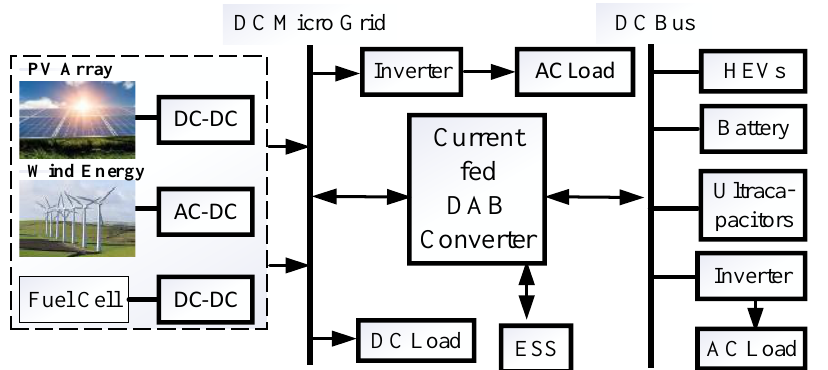
Figure 1. Block diagram of a distributed energy system.